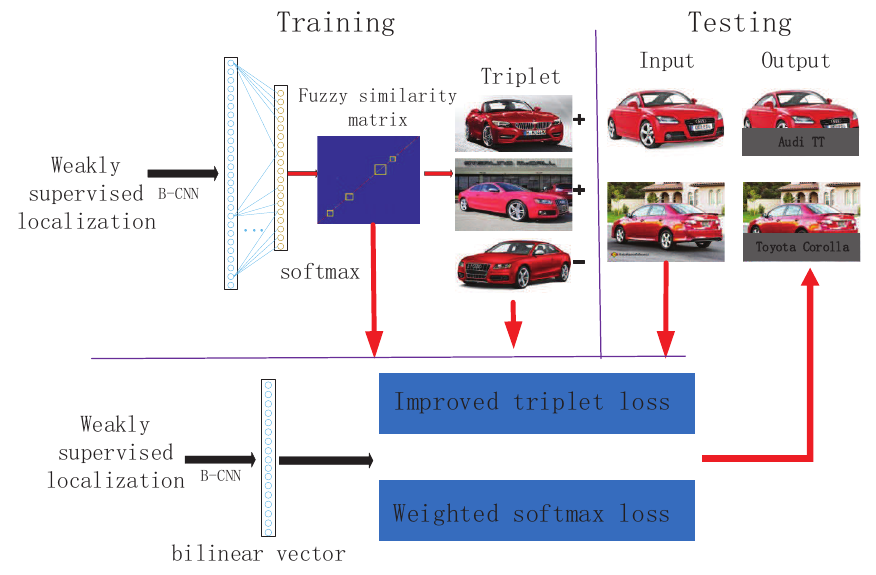
Figure 2. Schematic view of overall